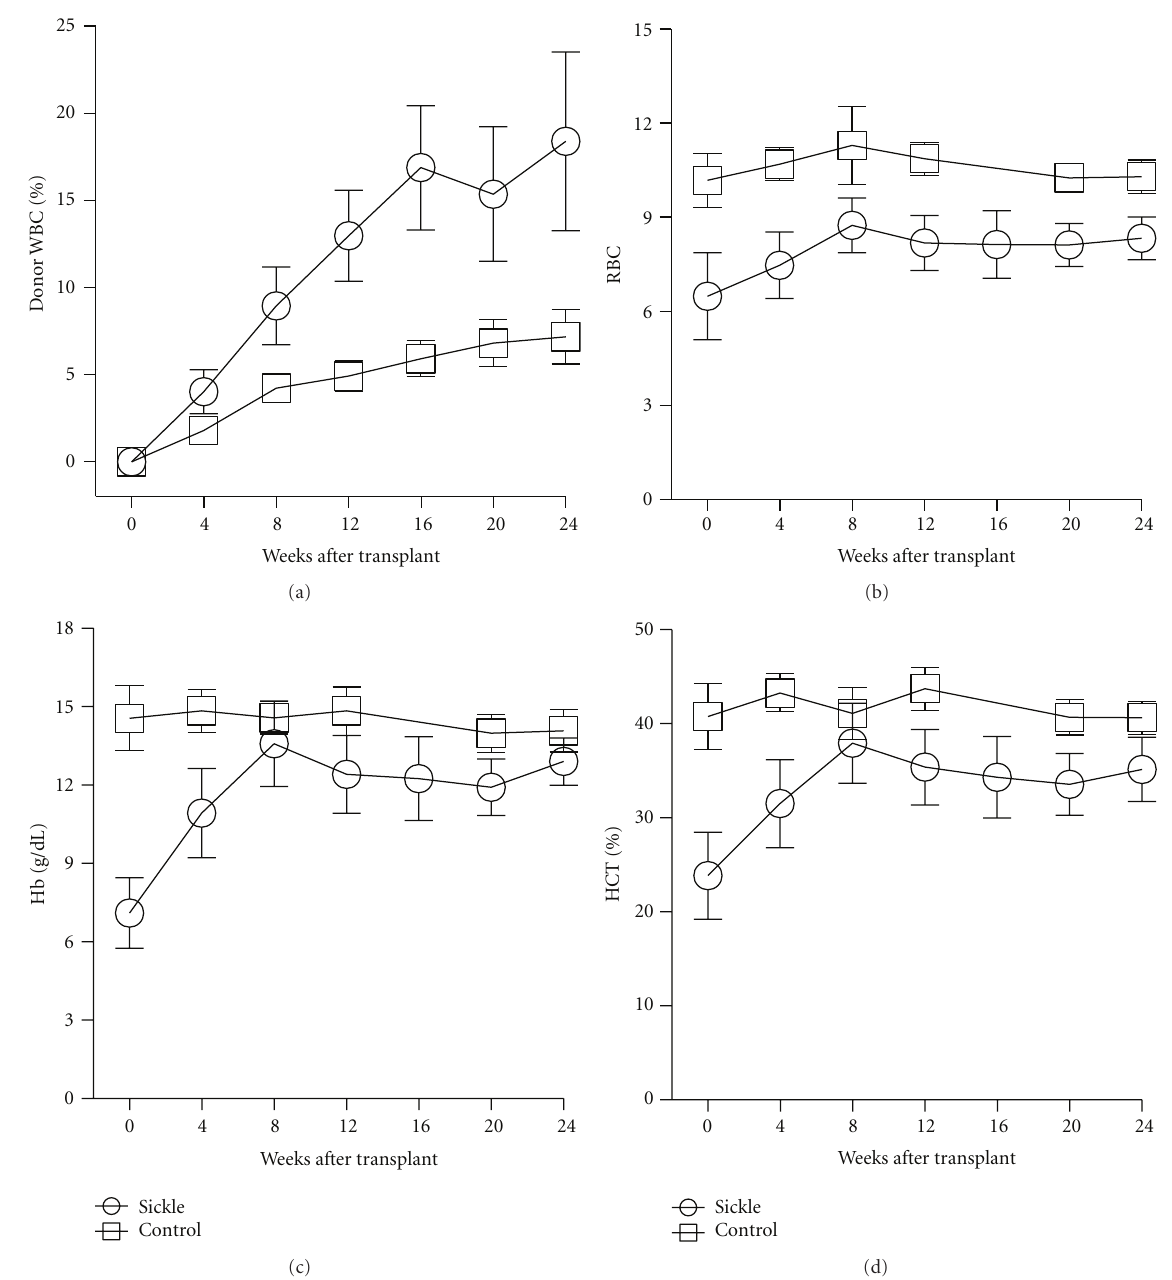
Figure 3: Preferential engraftment in sickle mice. (a) Peripheral WBC populations from normal mice engraft in homozygous sickle mice at a significantly ( P < 0 . 01) faster rate than control mice when transplanted without ablation but in the presence of costimulation blockade. The levels of WBC engraftment coincide with (b)–(d) corresponding correction of RBC, hemoglobin, and hematocrit in recipient mice.